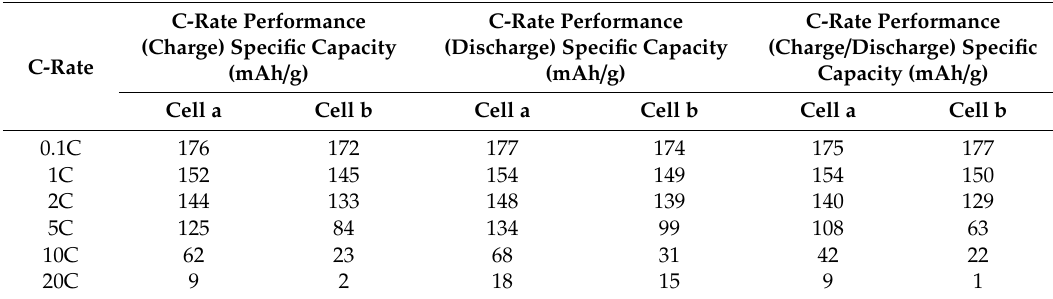
Table 2. Selected specific discharge capacities for the cells cycled with the BN-based electrolyte (cell a) and 1M LiPF 6 in EC:DMC (1:1) (cell b),